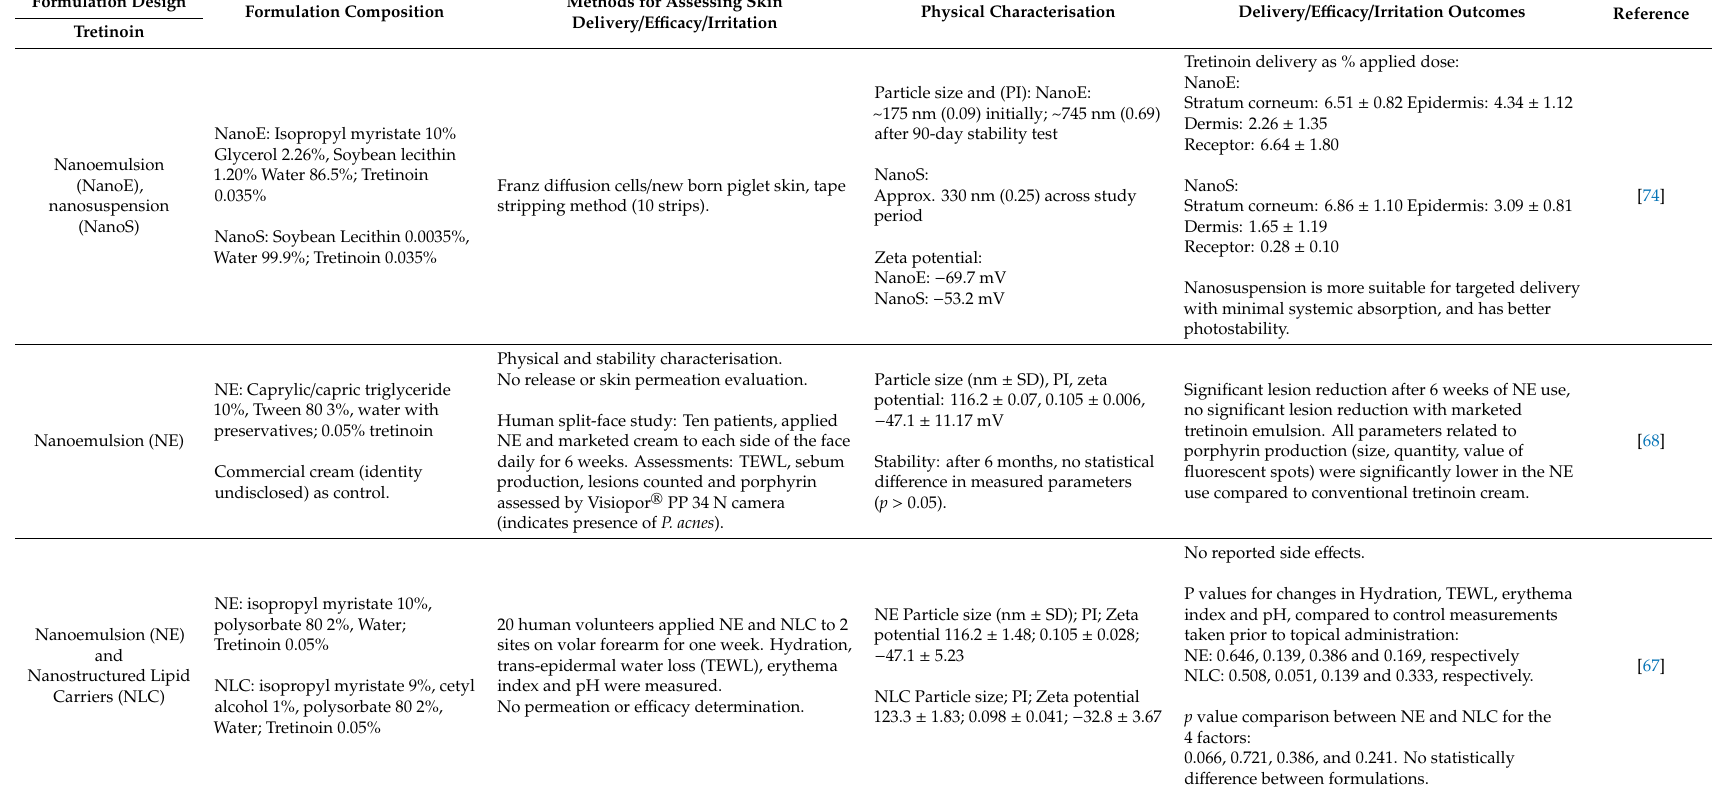
Table 3. Summary of research in targeted topical delivery of